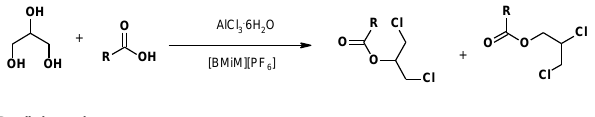
Figure 5. Synthesis of dichloropropyl esters from glycerol and a carboxylic acid, using an ionic liquid.